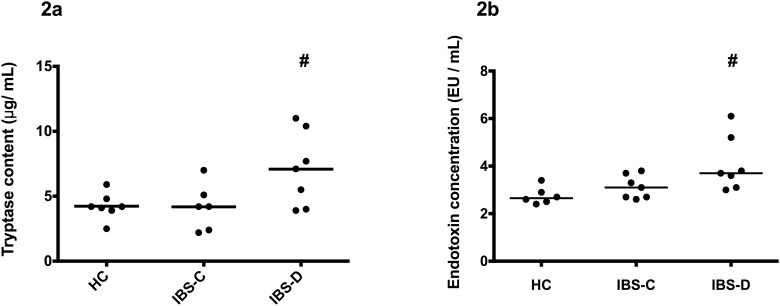
Median plasma TRYP (2a) and LPS levels (2b) in healthy controls (HC, n = 7 and n = 6, respectively), constipation-predominant (IBS-C, n = 7) and diarrhea-predominant IBS patients (IBS-D, n = 7); 2a #P < 0.05 compared to HC and IBS-C; 2b #P < 0.05 compared to HC only.Experiments were carried out three independent times.